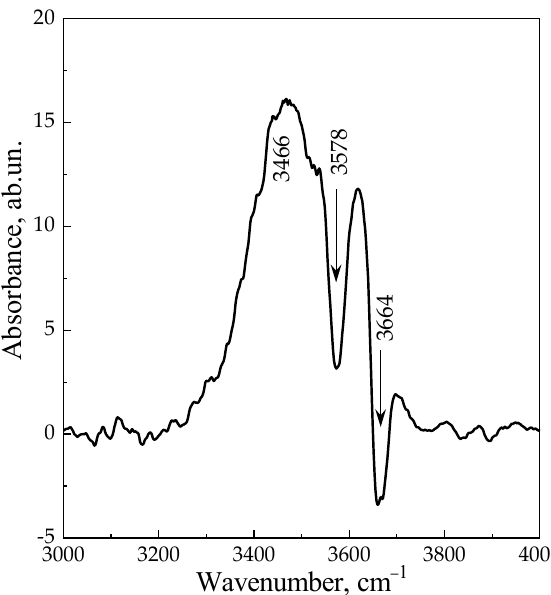
Figure 9. The difference spectrum obtained by subtracting the spectrum after adsorption of CO on the am -300 sample at 77 K and p = 10 Torr (Figure 8) from Curve 2 in Figure 6. Undoubtedly, a comparison of the obtained data on H-LSX acidity with those known for faujasites with different Si/Al ratios was of particular interest. Figure 10 shows the values of the proton affinity (a) and concentration of BASs (b) depending on Si/Al ratio. There is the increase in the PA with aluminum content in faujasites, and our current data follow the trend. This trend corresponds to the next nearest neighbors (NNN) model [107– 109], which assumes the acid strength of BASs increases with the content of Si neighboring Al. Otherwise, the isolated –Si–O(H)–Al– groups have stronger acidity compared to asso- ciated Al–(SiO(H)) 4 clusters. Unfortunately, poor stability of the associated Al–(SiO(H)) 4 clusters results in a significant decrease in the BAS concentration compared to the assum- edly possible accounting concentration of Al in LSX. According to our data, the concen- tration of BASs in LSX faujasite is greater than that for Y zeolites with an intermediate module of ~10–30 (Figure 10b).